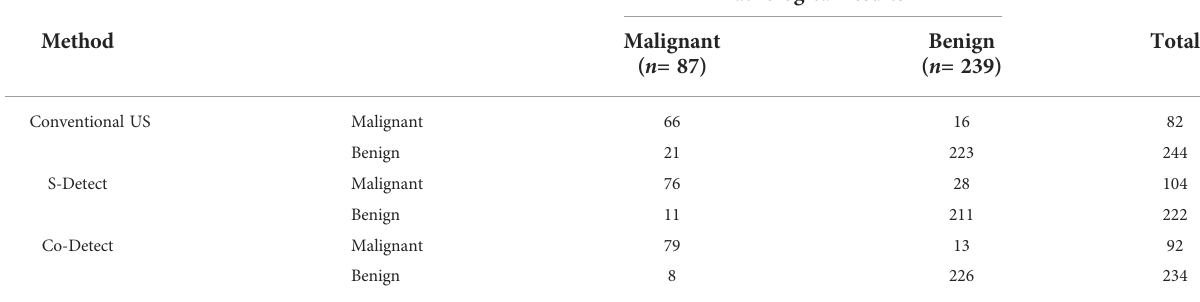
TABLE 2 Ultrasonic diagnosis of different detected methods.